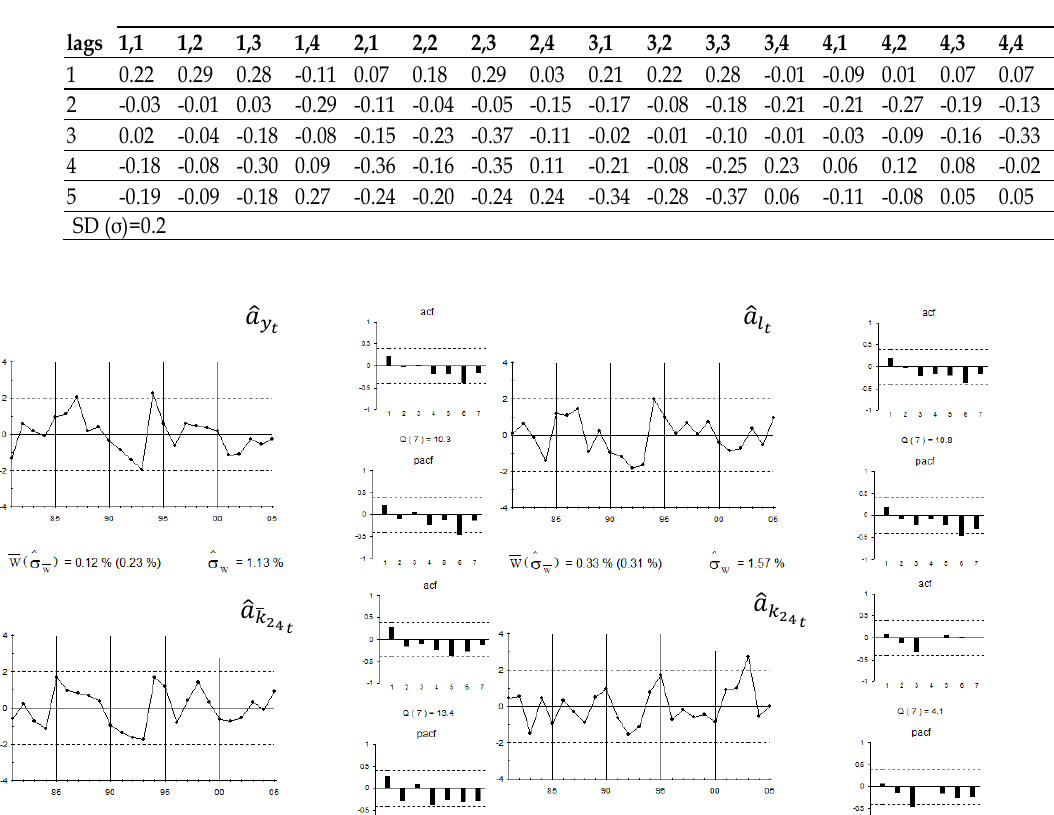
Table 8. Cross Correlation residual Function values (CCF). Airport Infrastructure Capital Stock